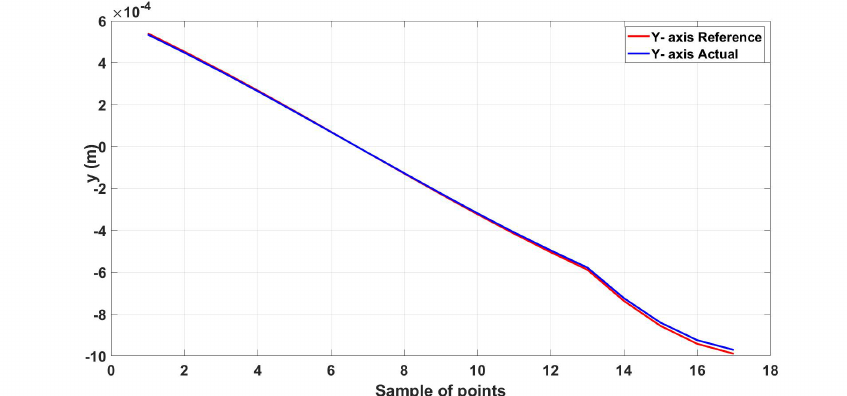
Figure 13. Actual and reference position of the diamond trajectory in the y-axis.